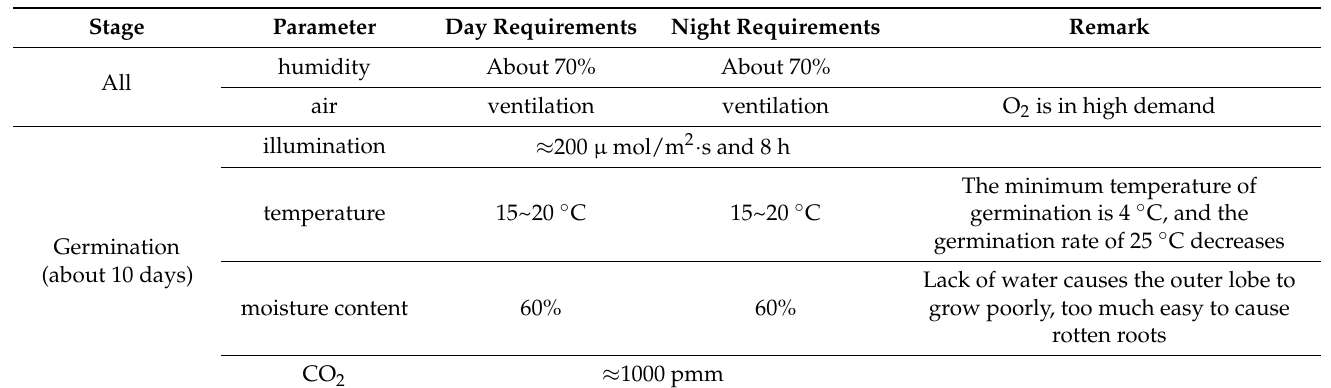
Table 6. Italian lettuce cultivation program.